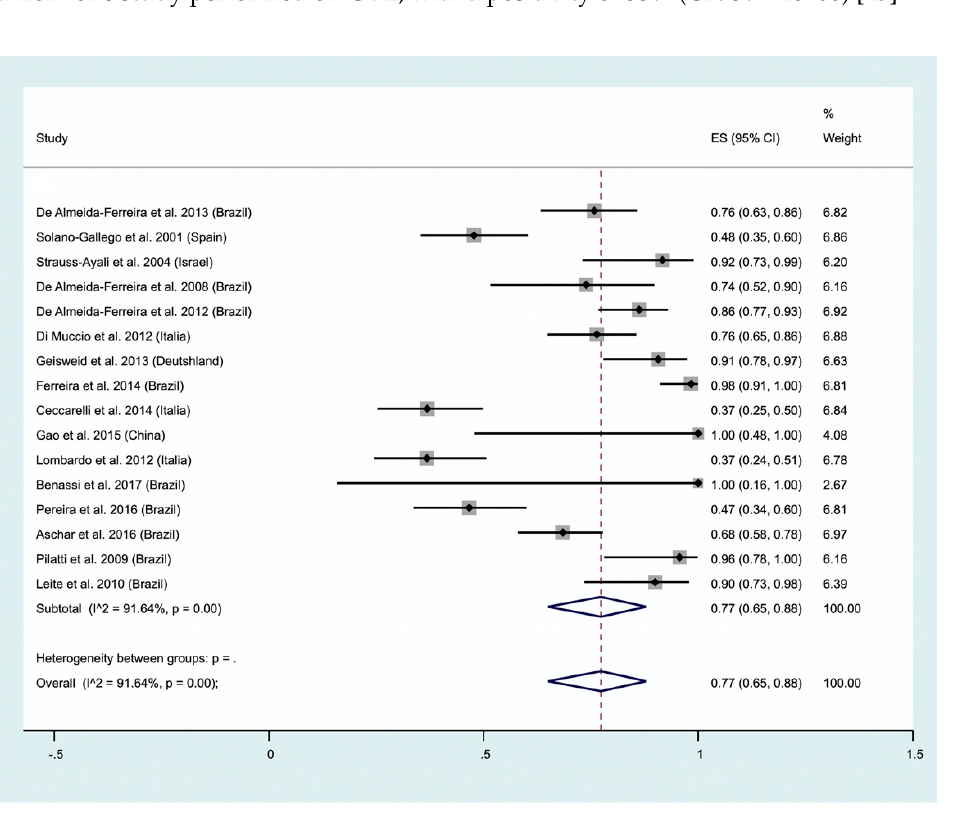
Figure 8. Forest plot representation of the extracted data for conjunctival swab/lacrimal fluid using molecular detection methods on canine visceral leishmaniasis.